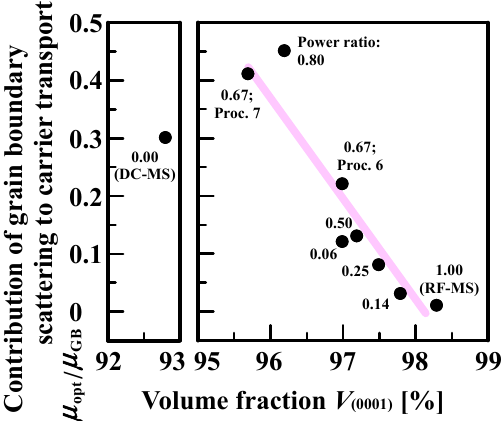
Figure 8. Contribution of grain boundary scattering to carrier transport ( μ opt / μ GB ) as a function of volume fraction of (0001) orientation ( V (0001) ) of 500-nm-thick AZO films deposited by DC magnetron sputtering (DC–MS) and RF/DC magnetron sputtering at various power ratios, and by RF magnetron sputtering (RF–MS).